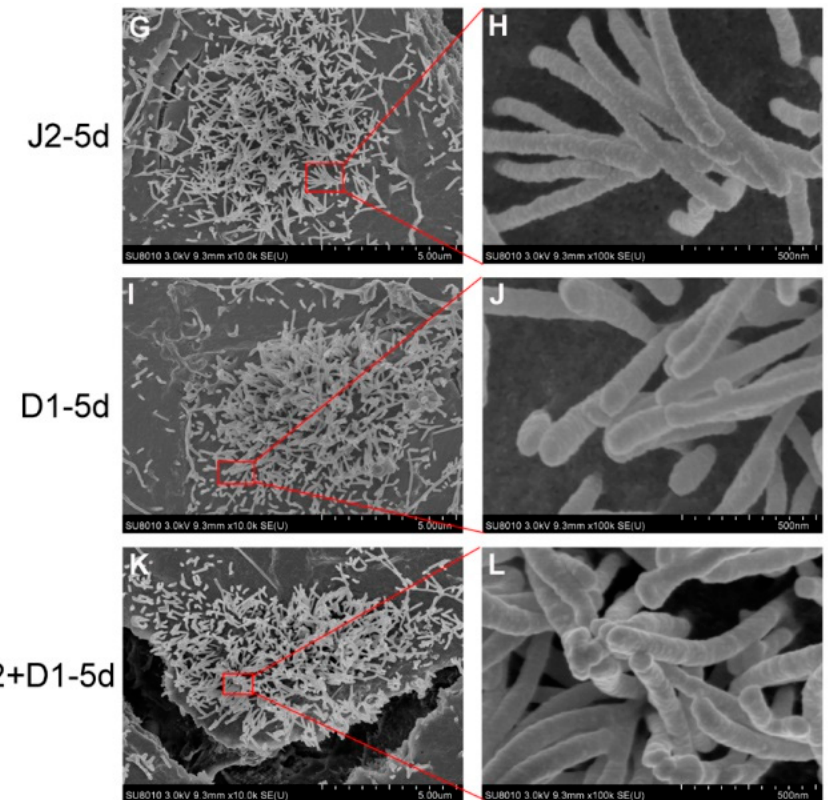
Figure 4. Scanning electron microscopy (SEM) analysis of hair cell-like cells from six infection schemes. ( A , B ) Stereocilia-like structures on the surface of hair cell-like cells induced from cells infected with NC-shRNA on day 6 of otic progenitor differentiation as the representative of all controls (Control). ( C , D ) No stereocilia-like structures were detected on the surface of hair cell-like cells induced using the J1-6d infection scheme. Stereocilia-like structures were detected on the surface of hair cell-like cells induced using the J1-12d ( E , F ), J2-5d ( G , H ), D1-5d ( I , J ), and J2+D1-5d ( K , L ) infection schemes.